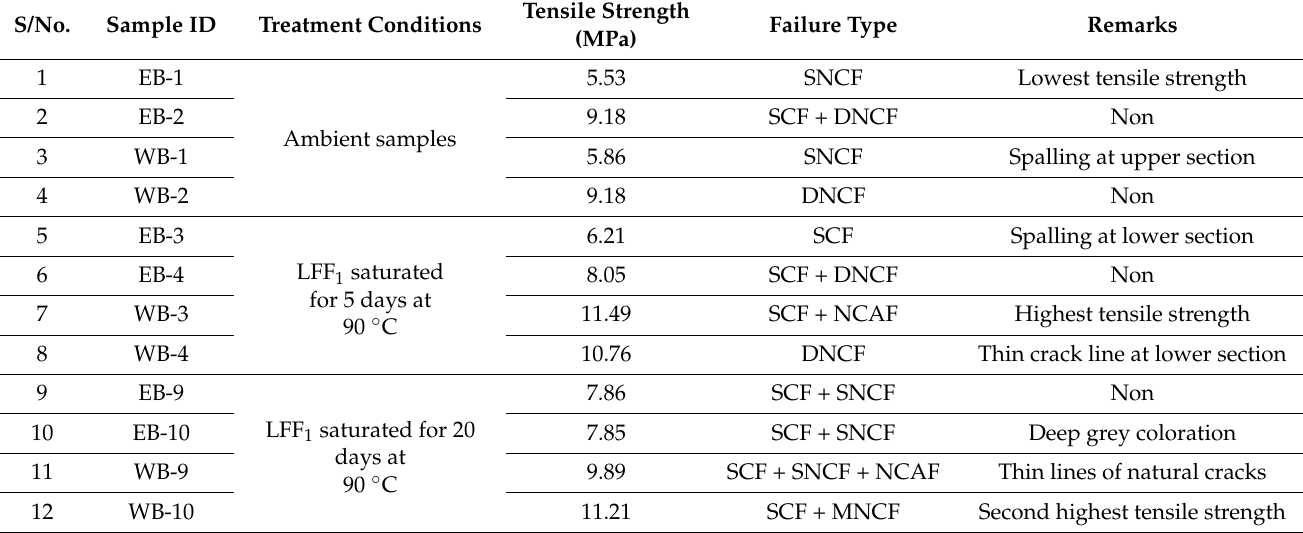
Table 1. Tensile failure analysis of samples with indications of their treatment conditions prior to BITS testing. Identified failure patterns included SCF, SNCF, DNCF, MNCF, and NCAF. Sample S/No. ID